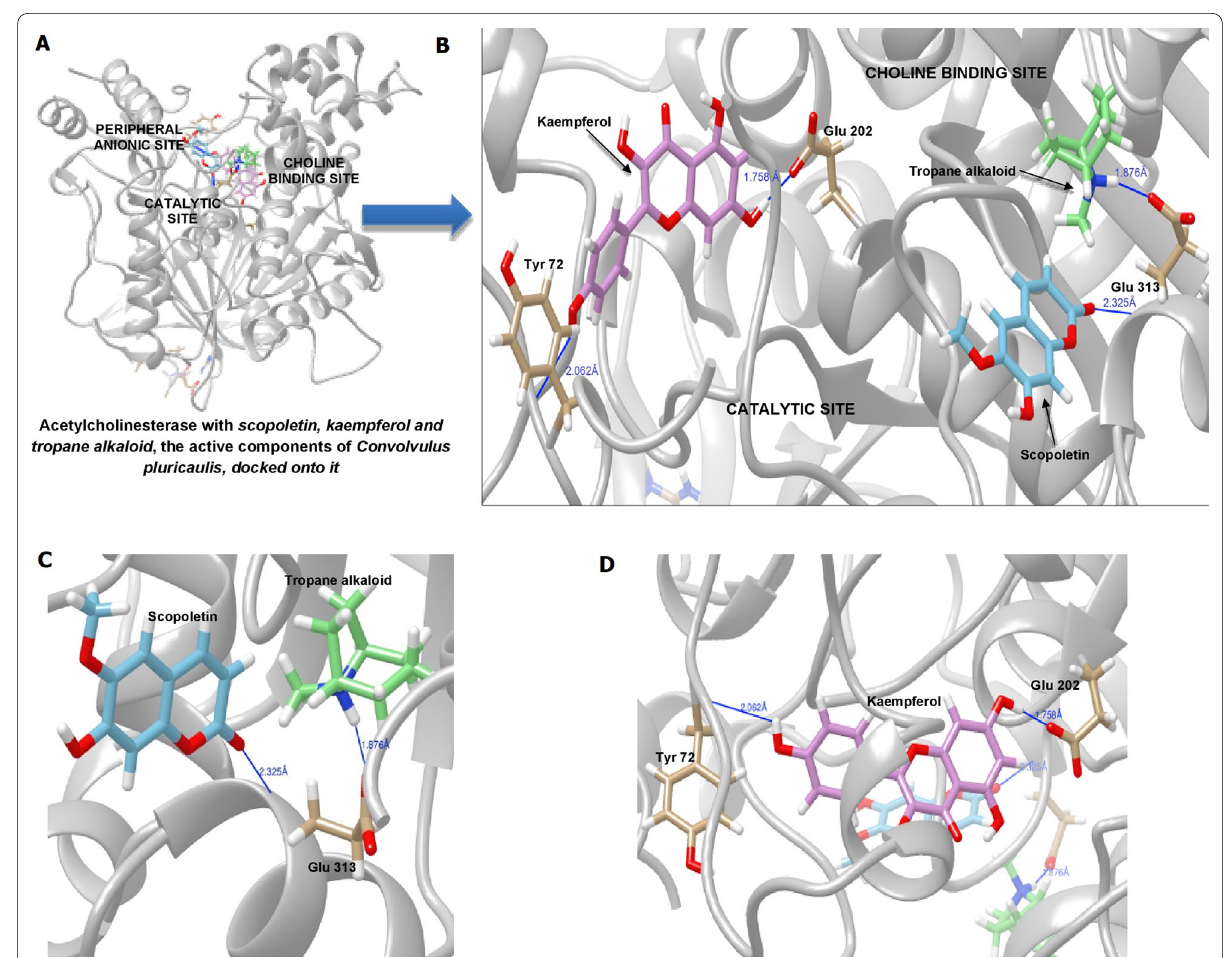
Fig. 6 Binding of Convolvulus active components to acetylcholinesterase. A , B Various pockets on acetylcholinesterase to which the active components, namely, scopoletin (and its central tropane alkaloid structure) and kaempferol, were bound, C Scopoletin and tropane alkaloid at Glu313, D Kaempferol binding at Tyr72 and